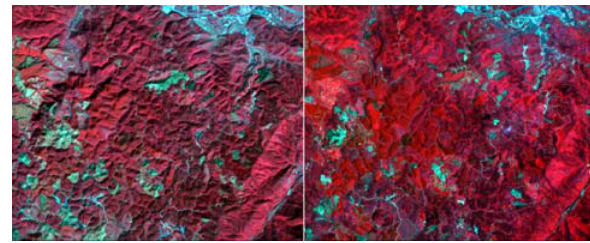
Fig.1a image of 14 Jan.,2015 Fig.1b image of 24 Aug.,2015